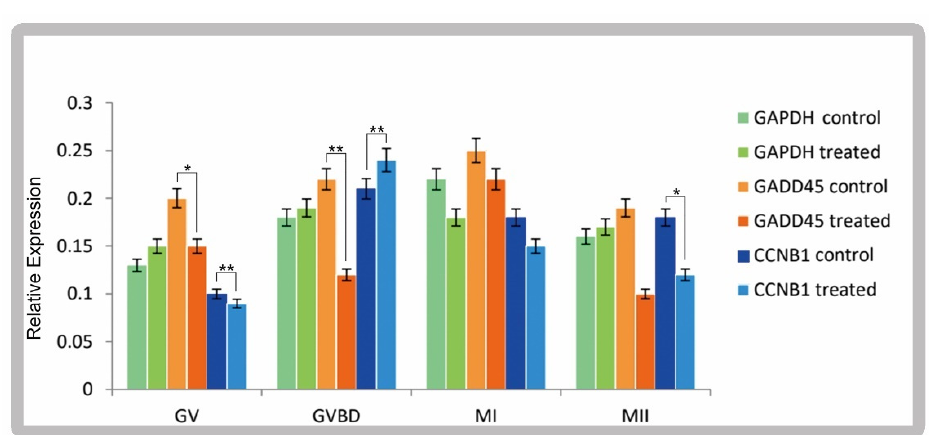
Figure 2. Relative expression of GADD45 and CCNB1 at different stages of IVM oocyte. Error bars indicate three independent biological replicates (mean ± standard deviation). * p < 0.05, ** p < 0.01.